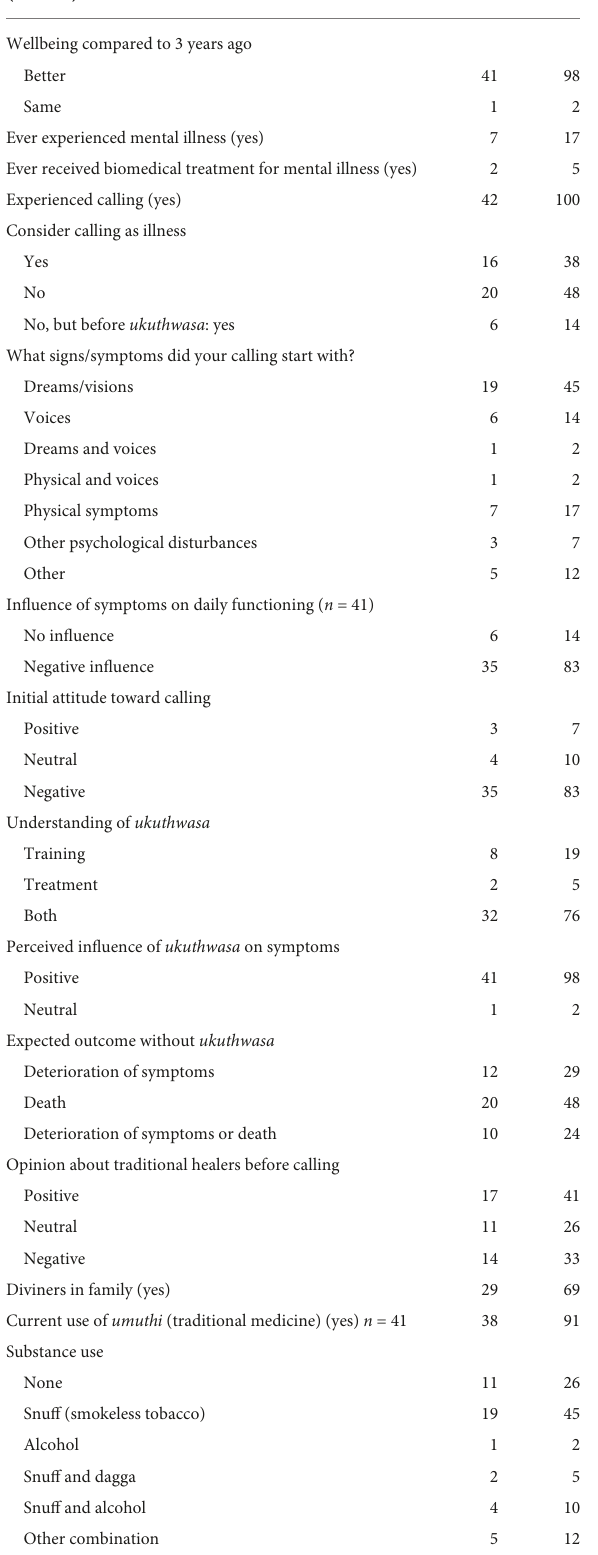
TABLE 5 Selected questions from qualitative